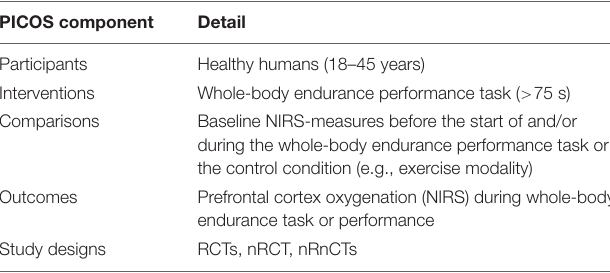
TABLE 1 | “PICOS” categories (participants, interventions, comparisons, outcomes, study design) used to determine